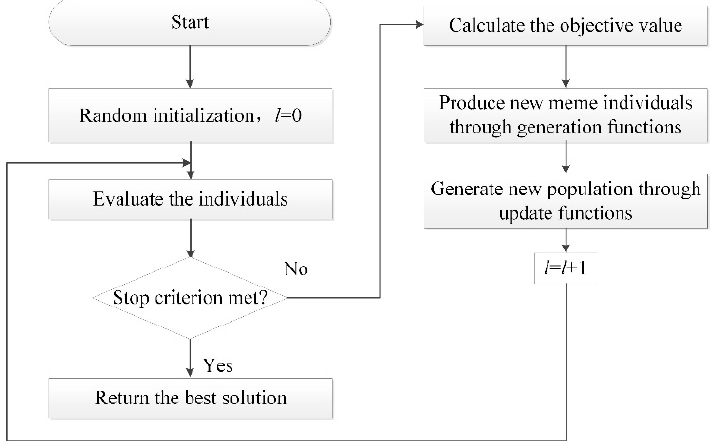
Figure 5. Flow diagram of standard MA.